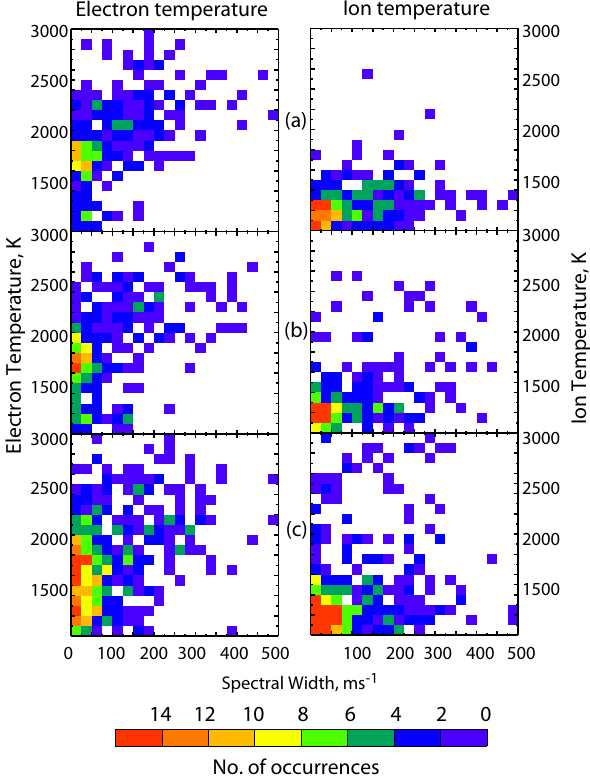
Fig. 3. Left column is electron temperature from the two main- land EISCAT beams and the ESR beam, vs. spectral width from the CUTLASS Finland radar. The data is restricted to 71 ◦ to 72 ◦ latitude AACGM to cover only a small range of altitudes in the F- region from all of the radar beams. Row (a) EISCAT beam 1, (b) EISCAT beam 2, and (c) ESR. The right column shows the same but for ion temperature.